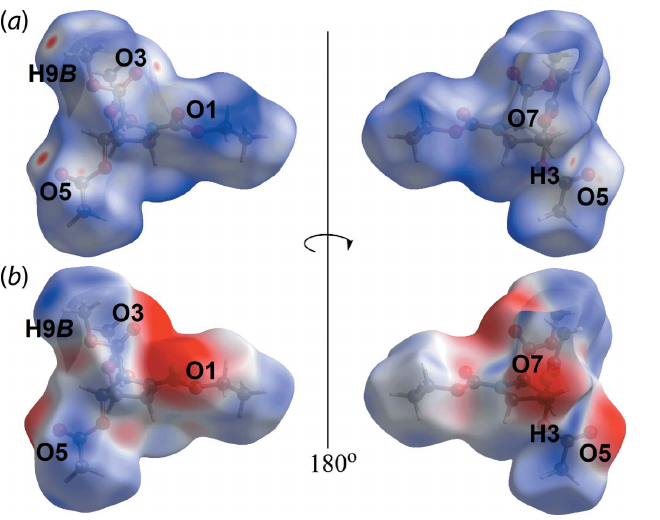
Figure 4 Two views of the Hirshfeld surface mapped for (II) over ( a ) d norm in the range of (cid:6) 0.083 to +1.828 arbitrary units and ( b ) the calculated electrostatic potential in the range of (cid:6) 0.077 to 0.054 a.u.